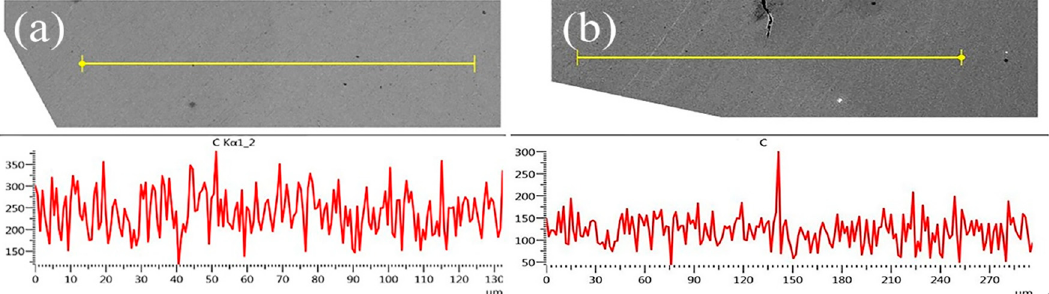
Figure 10. The element line scanning at the crack tip: ( a ) before CBB test; ( b ) after CBB test.